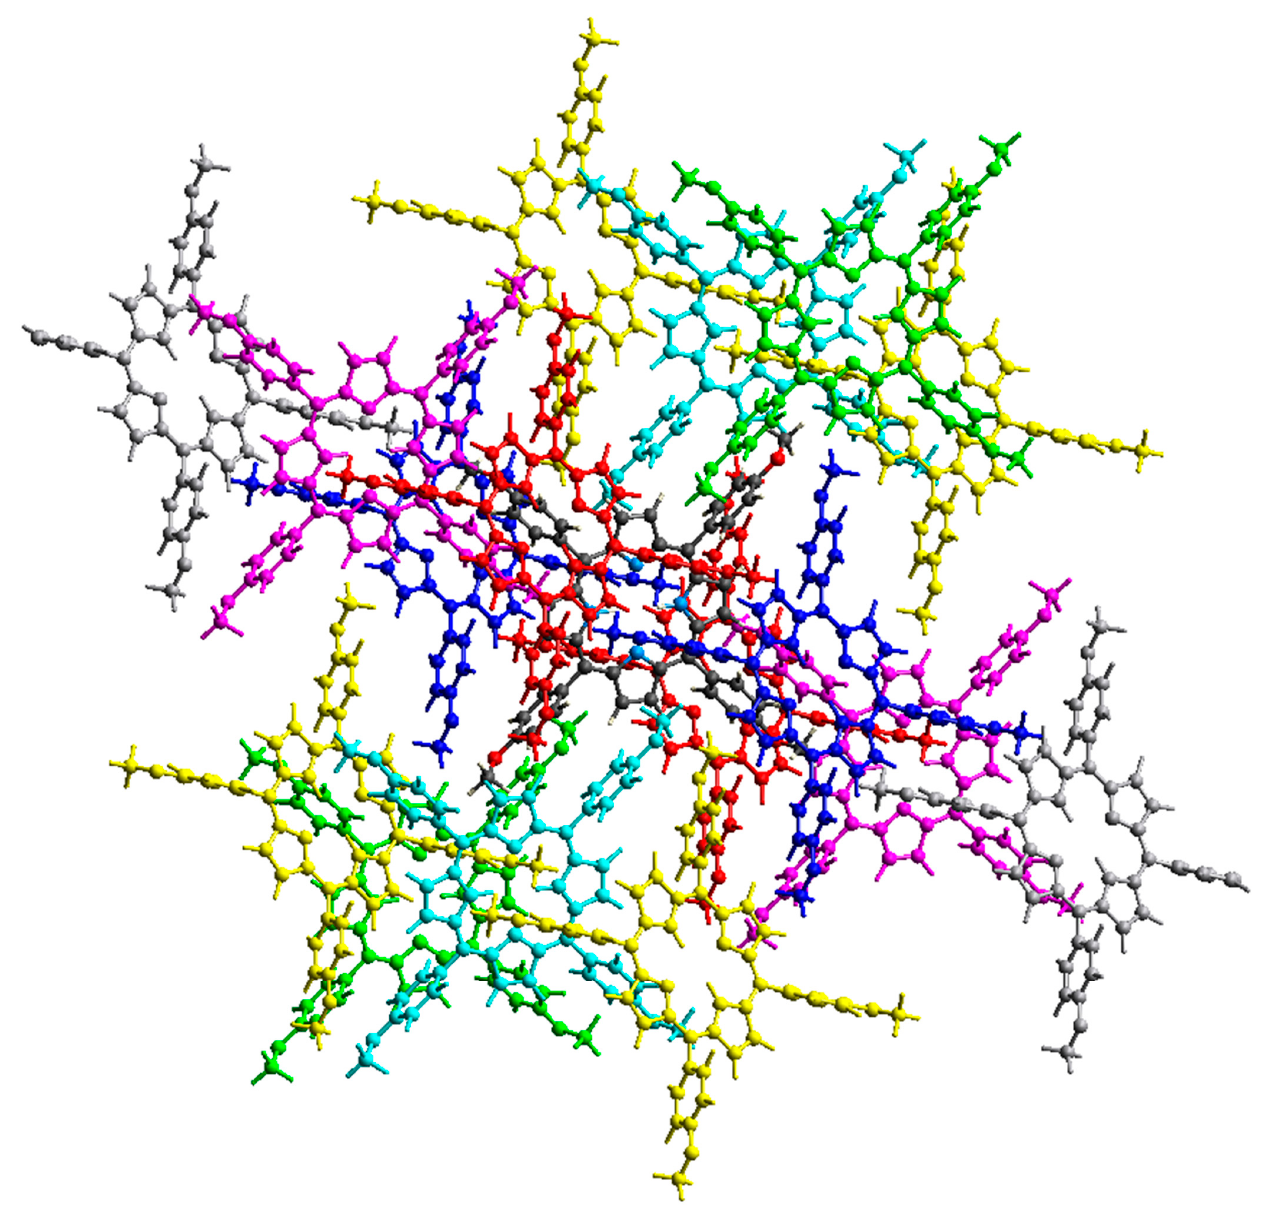
Figure 5. Intermolecular interaction energies between neighboring H 2 -TMPP molecules.